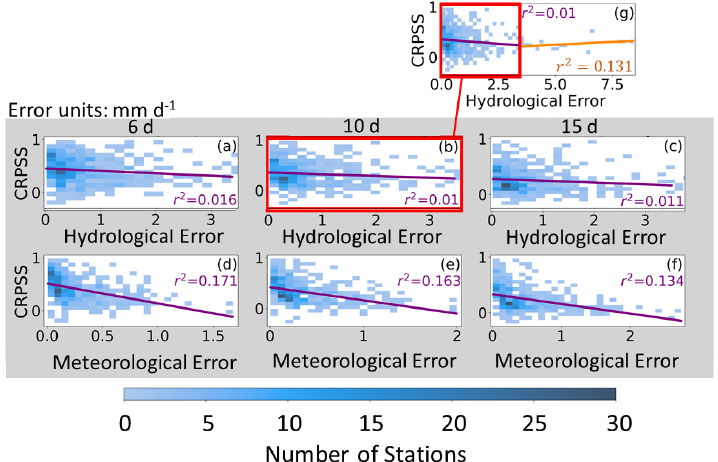
Figure 12. Density plots showing the station CRPSS for lead times of 6d (a, d) , 10d (b, e) , and 15d (c, f) against hydrological error (a–c) and meteorological error (d–f) . The largest 15 hydrological errors are excluded from panels (a) to (f) . See Sect. 5.2.1 for an explanation of the metrics used to represent the hydrological and meteorological errors. Purple lines show the line of best fit calculated using linear regression, and the associated r 2 are given within each panel. (g) The CRPSS against hydrological error including the 15 largest hydrological errors for a lead time of 10d. The orange line shows the line of best fit for the station with large hydrological